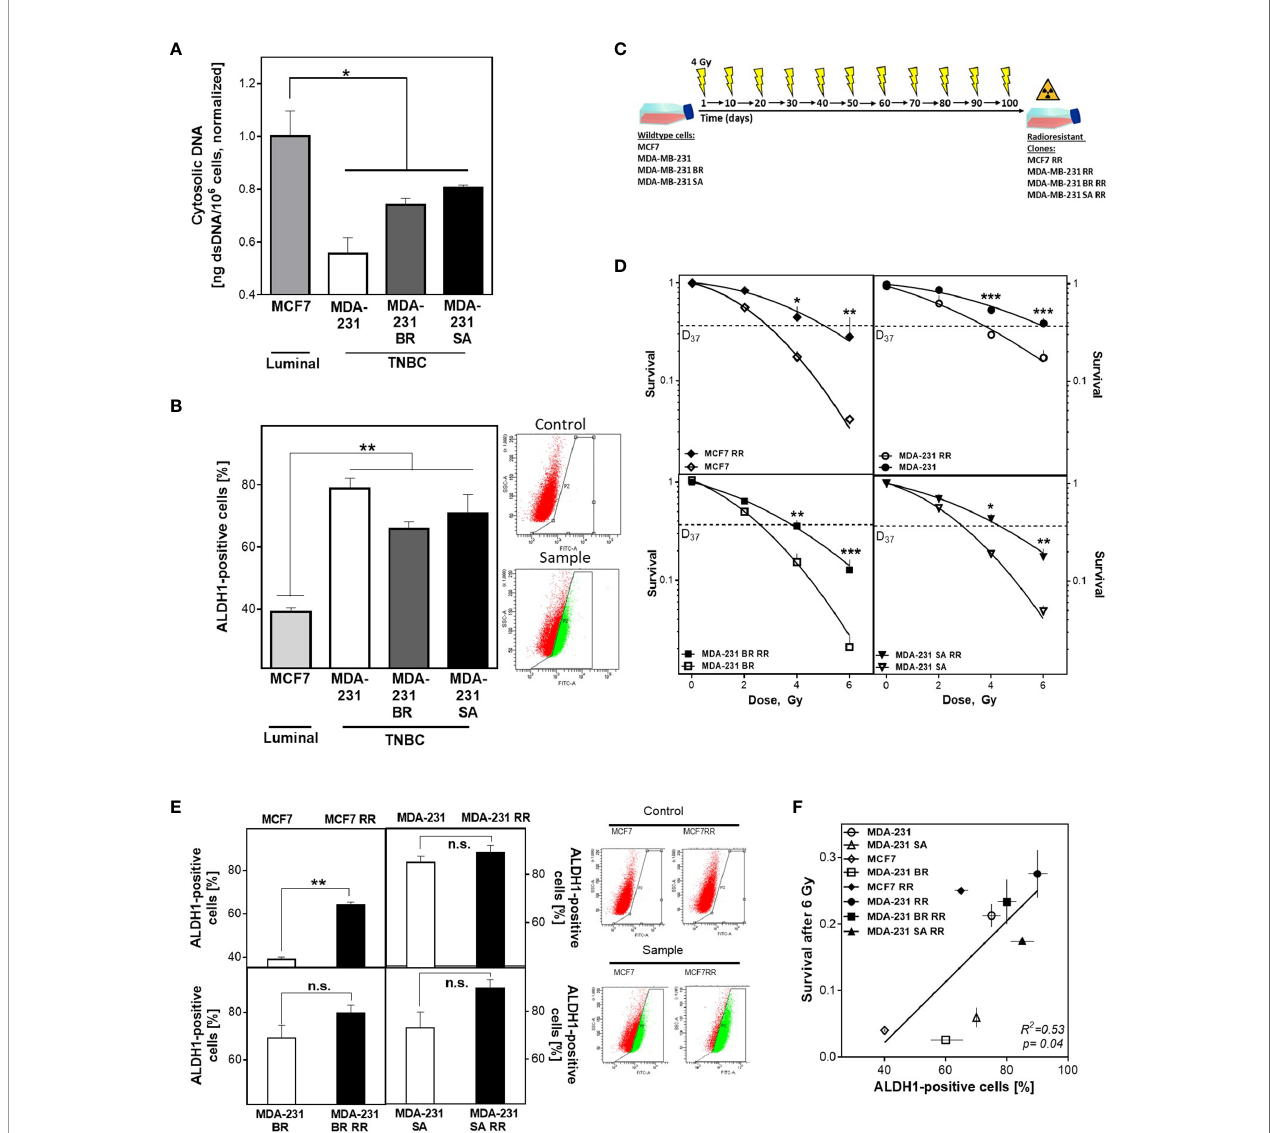
FIGURE 1 | BCSC proportion correlates with cytosolic DNA and radioresistance. (A) Cytosolic dsDNA in TNBC and luminal cells. Cytoplasmatic fractions were isolated, dsDNA stained with PicoGreen ® reagent and quanti fi ed in a Spark ® reader. (B, E) Detection of ALDH1 positive cells. Cells were treated with ALDEFLUOR ™ reagent, harvested and the ALDH1 positive cells quanti fi ed by FACS. (C) Scheme to generate radioresistant sub cell lines. Cells were irradiated, pooled, and irradiated again after two weeks. The procedure was repeated ten times. (D) Cellular survival after irradiation. Cells were seeded 6 hours prior to treatment, irradiated with indicated doses, fi xed after 14 days and the numbers of colonies was counted. (F) Correlation of the percentage of ALDH1-positive cells and cellular survival. Shown are means from three independent experiments ± SEM. Asterisks (*) represent signi fi cant differences (n.s., not signi fi cant; *p < 0.05; **p < 0.01; ***p < 0.001; Student ’ s